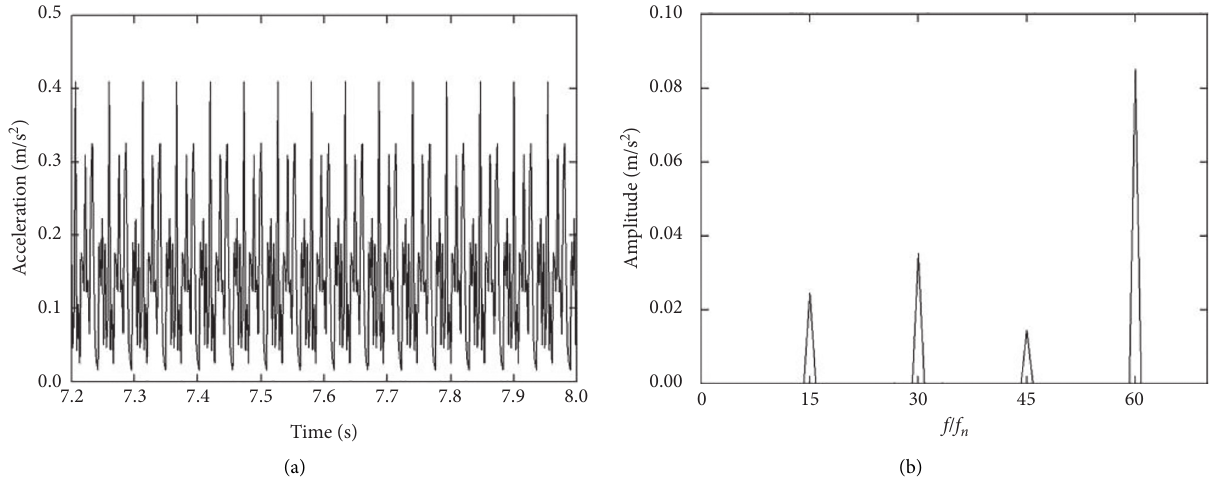
Figure 16: Acceleration fluctuation analysis of the extreme acceleration point ( C ). (a) Time-domain graph. (b) Frequency-domain